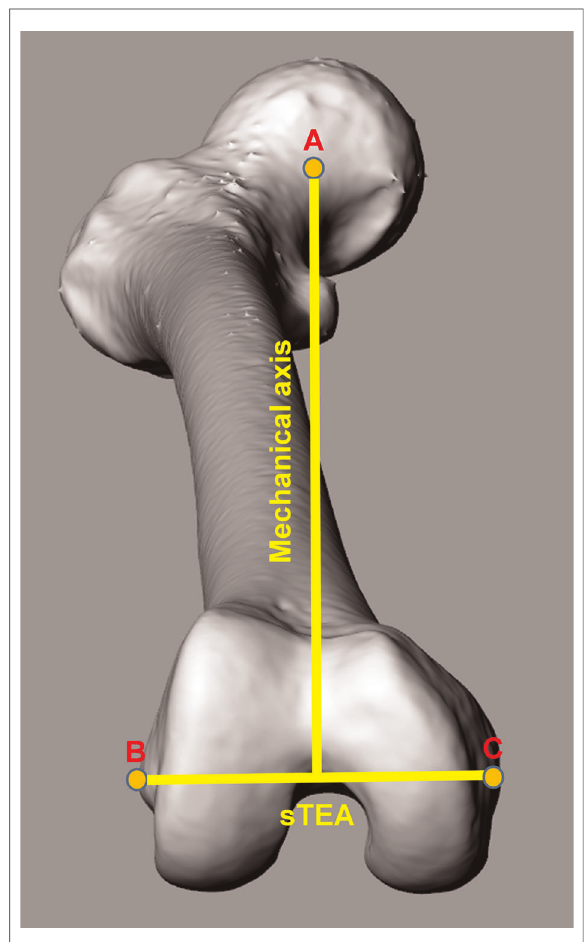
FIGURE 1 Coordinate system of femur. The surgical transepicondylar axis (sTEA) connecting the most convex point of the lateral condyle and the most concave point of the medial condyle was de fi ned as the X-axis. The mechanical axis (MA) running from the geometric center of the femoral head to the midway point of the sTEA was regarded as the Y-axis. Consequently, the Z-axis was perpendicular to the plane established by the X-axis and Y-axis. Point A represents the geometric center of the femoral head. Point B represents the most convex point of the lateral condyle. Point C represents the most concave point of the medial